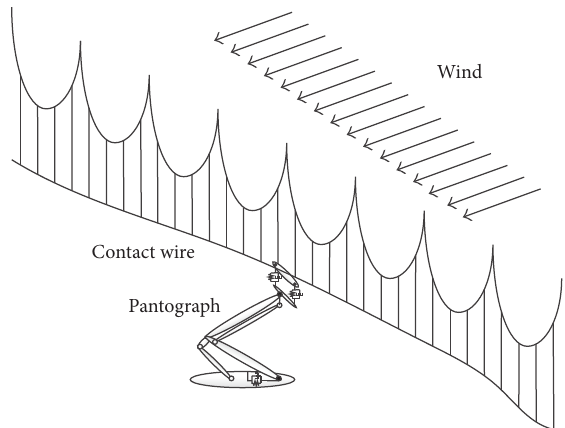
Figure 3: Pantograph-catenary system with wind load.